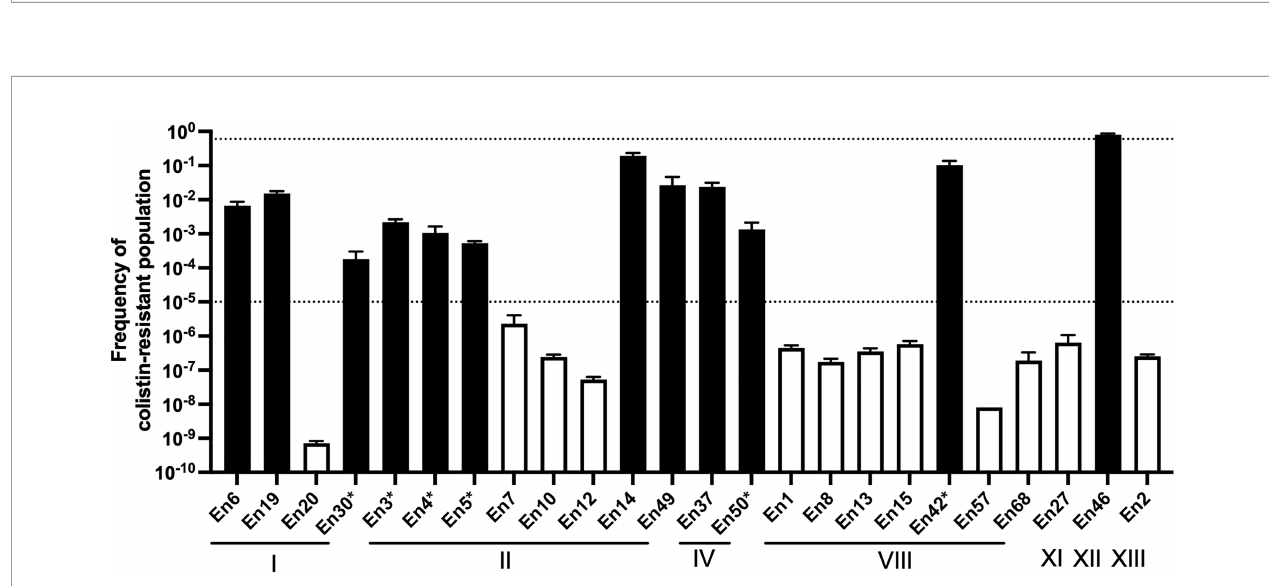
FIGURE 4 | Population analysis pro fi ling of colistin-resistant E. cloacae complex isolate-derived companion animals Broken lines indicate the frequency of colistin- resistant subpopulations (1 × 10 -5 ) that should in fl uence the colistin susceptibility test (after inoculation of 5 × 10 5 cfu/ml) as determined by CLSI guidelines (Clinical and Laboratory Standards Institute, 2020). Black and white bars indicate the frequencies of colistin-resistant populations in colistin-resistant and colistin-susceptible isolate cultures, respectively. *, isolates exhibited a “ skip-well ” phenomenon in A. Roman numerals indicate clusters by hsp60